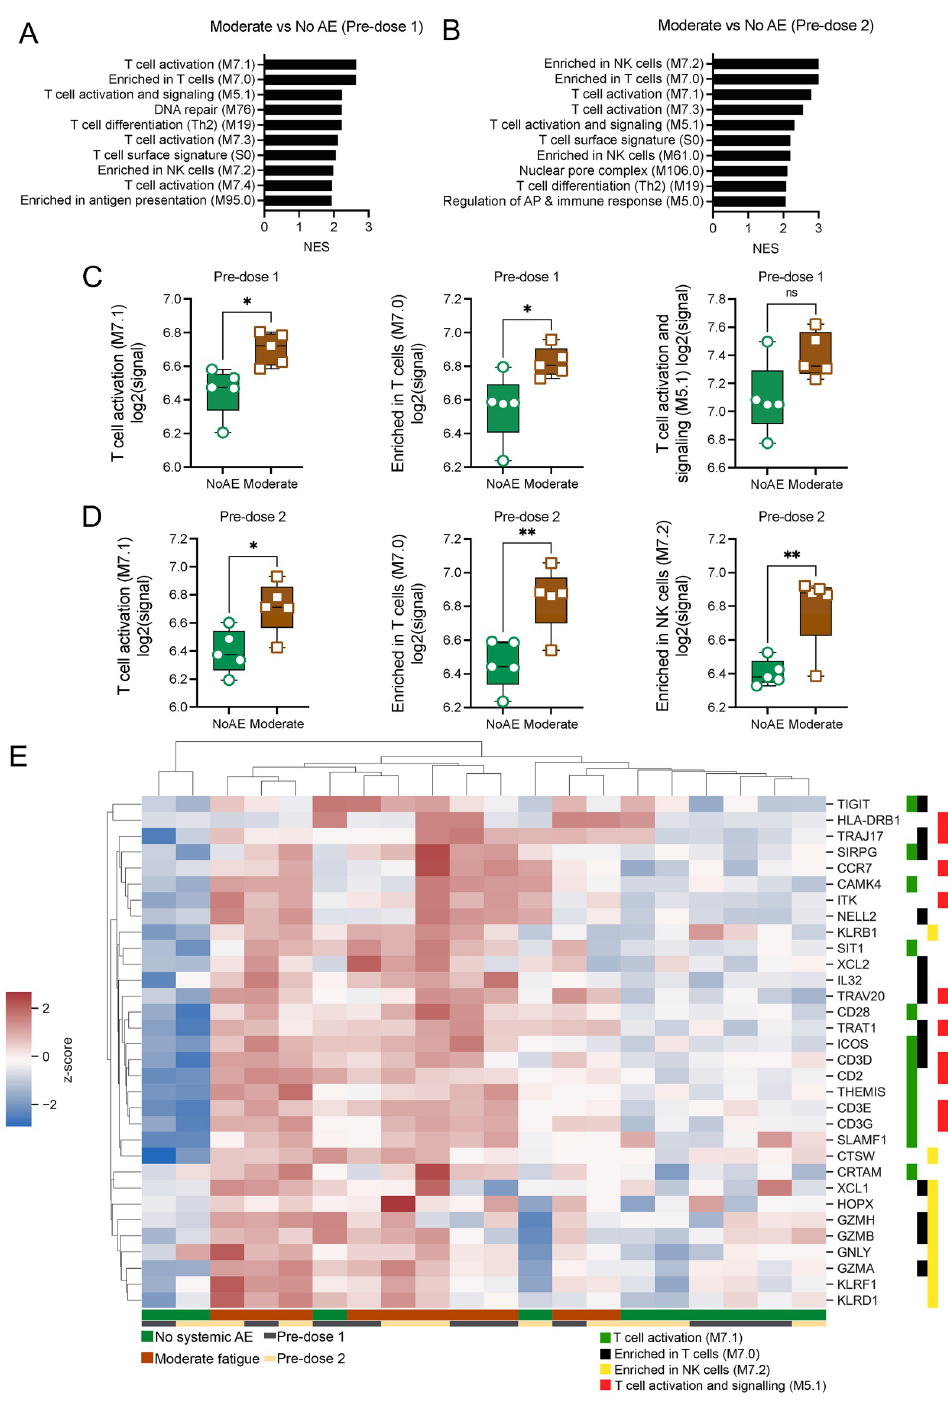
Fig 3. GSEA on whole genome transcripts from participants with moderately severe fatigue and their age- and gender-matched controls reveal differences in baseline expression of genes in T and NK cell–related pathways. Direct comparisons between moderately severe fatigue versus no systemic AE were made. Genes were preranked according to their log2FC for GSEA analysis using the BTM. (A, B) Top 10 positively enriched pathways in participants with moderately severe fatigue compared to no systemic AE at predose 1 (A) and predose 2 (B). NES values are displayed. FDR < 0.05 cutoff values were imposed. (C, D) Mean log2 signal of all genes in the top enriched pathways at predose 1 (C) and predose 2 (D), categorized by participants with either moderately severe fatigue or no systemic AE. (E) Gene expression of the top 10 LEGs in the top enriched pathways at predose 1 and 2. Z scores of raw log2 signal are displayed. Data presented as means ± SD. Unpaired Student t test were used for experiments comparing 2